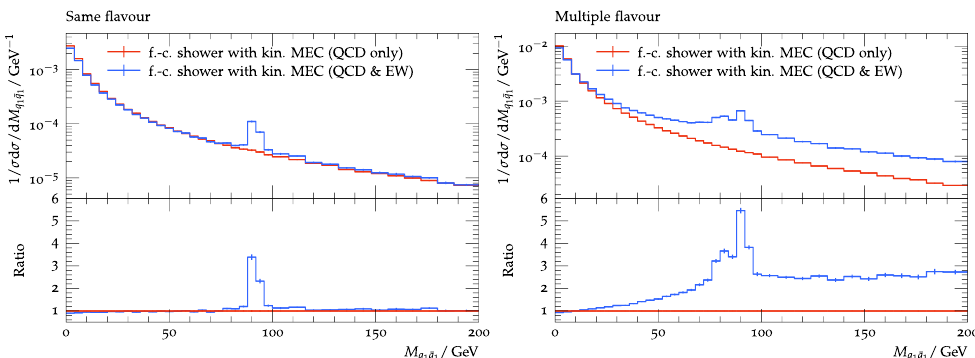
Figure 9: Same distributions as shown in fig. 8, but including the effect of W ± , Z and H bosons. For the considered CM energy of 1 TeV, the effects are very large, showing resonance-like structures for both same- and different-flavour configurations, and an overall enhanced distribution for the different-flavour